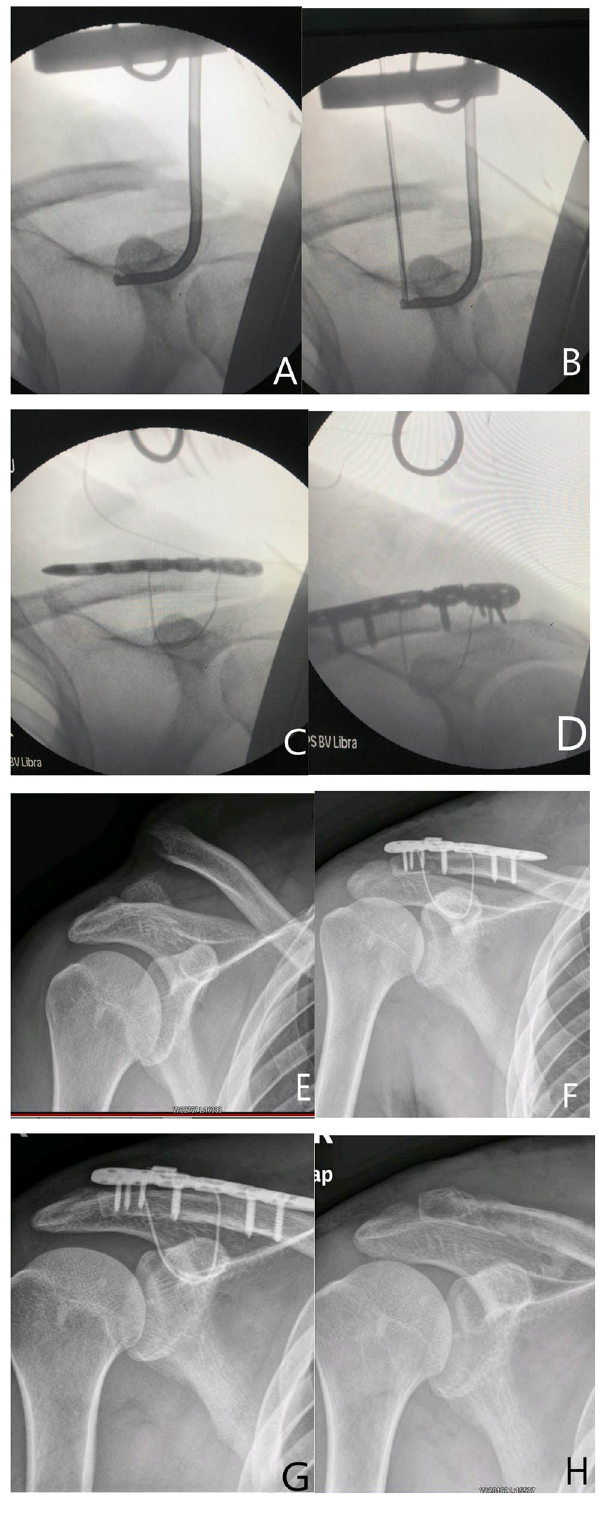
Figure 1. ( A , B ) The guide was inserted through the tunnel. ( C , D ) A titanium cable was inserted and the clavicle distal locking plate was fix. ( E – H ) A 27 years old man with right distal clavicle fracture. The distal fragment more than 2.5 cm, a titanium cable was inserted and the clavicle distal locking plate was fix. ( E ) Preoperative X-ray of the shoulder; ( F ) postoperative X-ray, ( G ) 3 months after operate and fracture healing, ( H ) the final follow-up 12 months after surgery and the implant